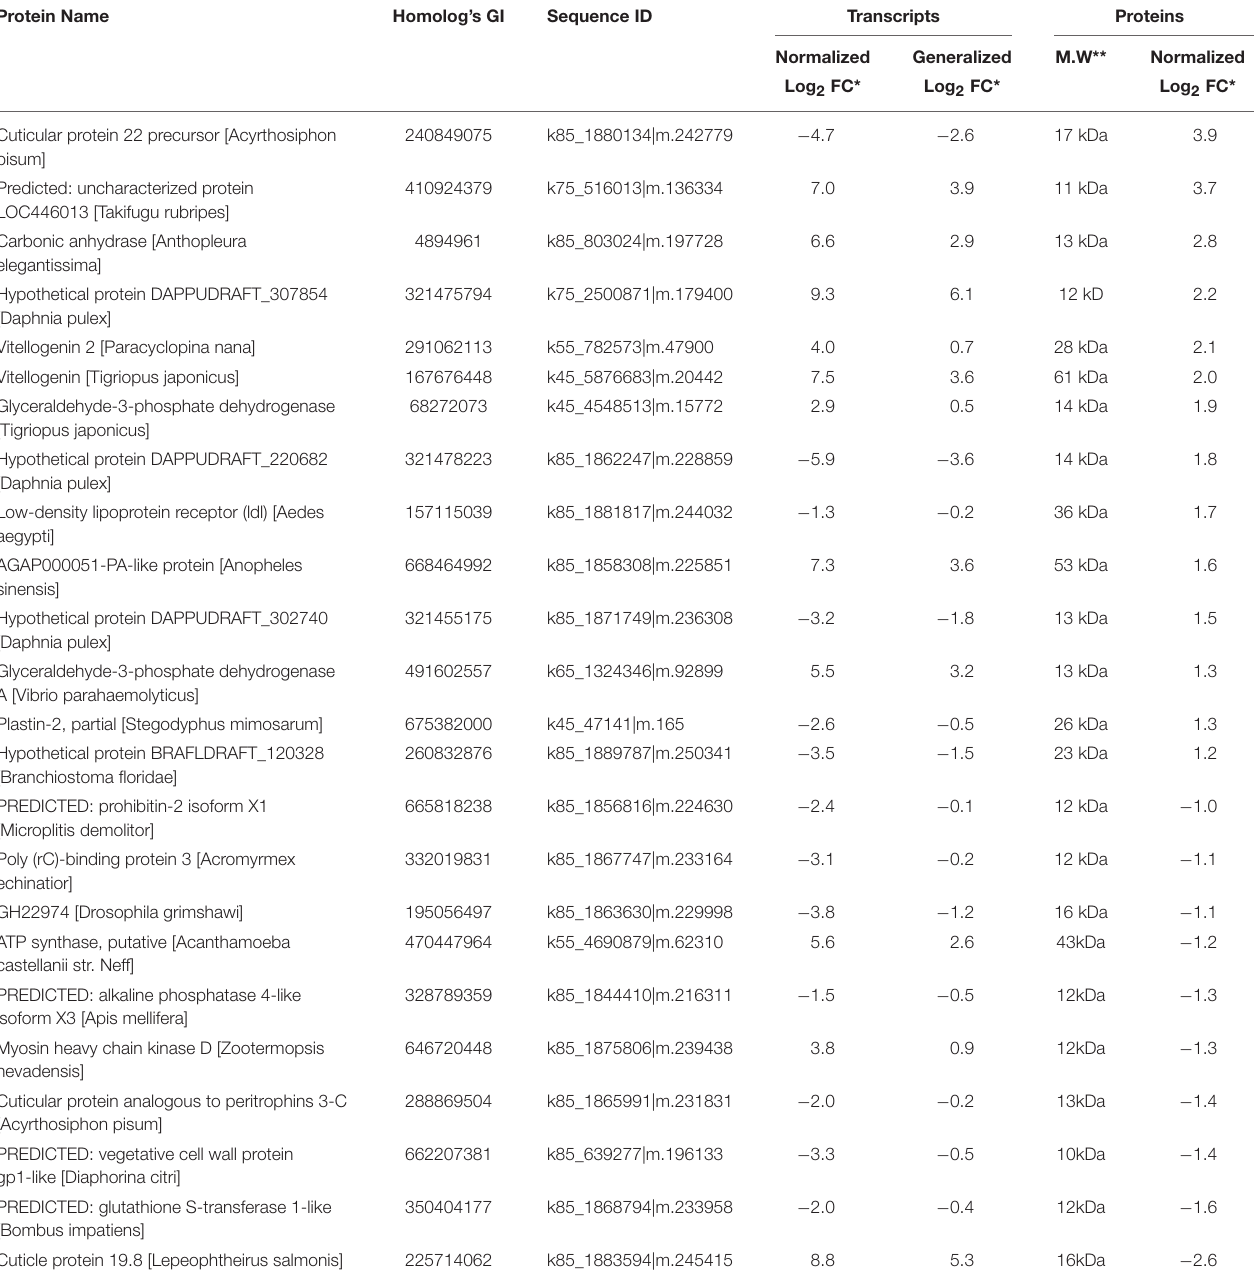
TABLE 4 | Top up/down differentially integrative transcriptomic and proteomic data between Nauplius II and Nauplius